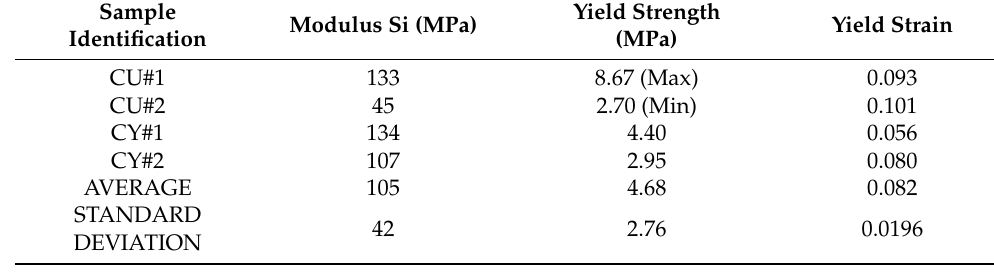
Table 2. Properties obtained on the first cadaver (21M) of cubic and cylindrical bone samples.